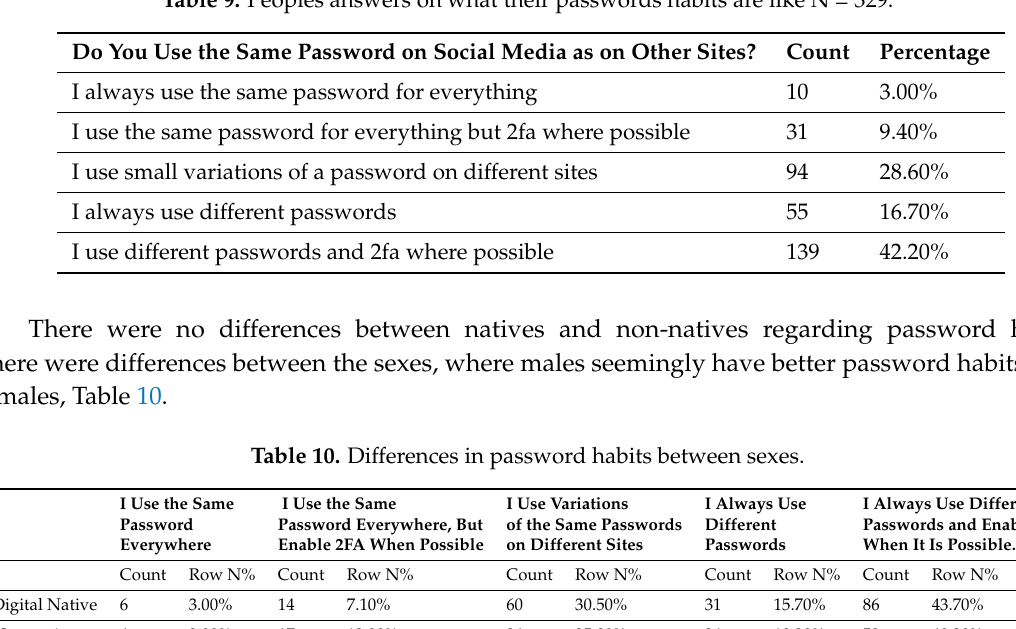
Table 9. Peoples answers on what their passwords habits are like N = 329.